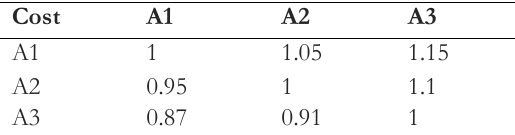
Table 5. Suppliers compared with cost.